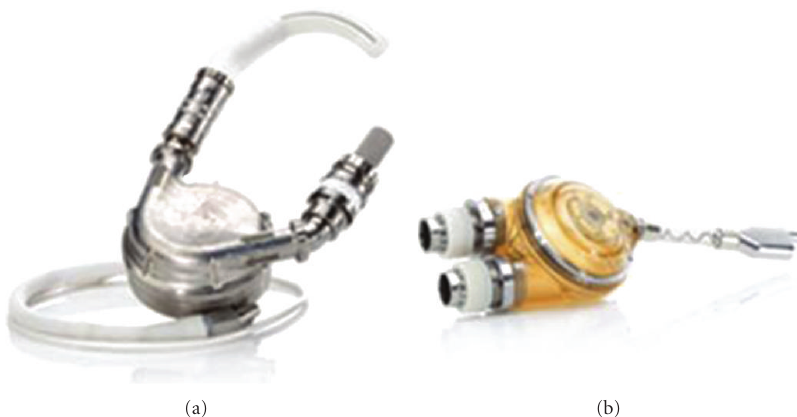
Figure 1: First generation pulsatile left ventricular assist device HeartMate XVE (a) and Thoratec paracorporeal device (b).